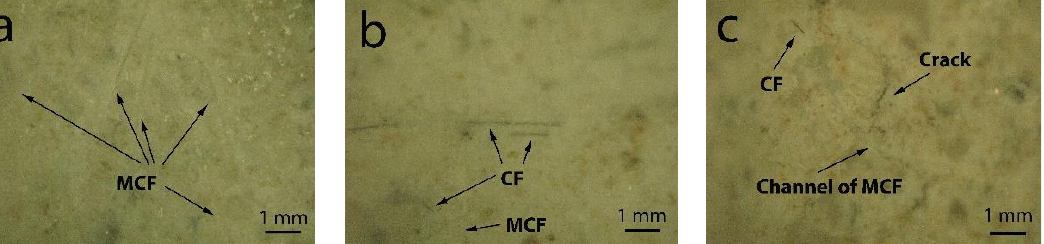
Figure 7. Macrostructure of the samples zoomed in 100 times: ( a ) without adding CF (E sample); ( b ) after adding CF (AP050 sample); ( c ) after fire temperature exposure (AP050 sample).